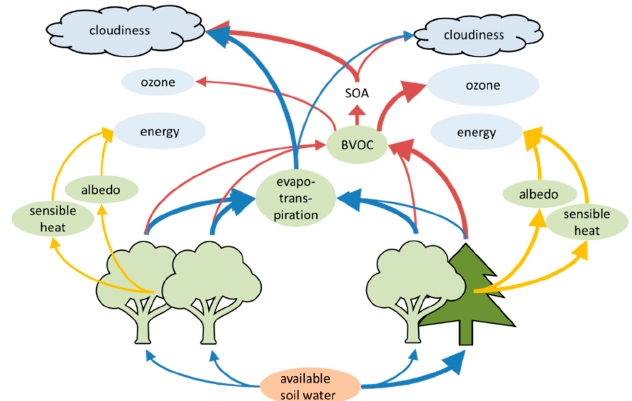
Figure 1. Impacts of beech forests (left) in comparison to mixed beech / fir forests (right) on heat-, water-, and biogenic volatile organic compound (BVOC) exchange (green ellipses) as well as on energy, clouds, and air chemistry (blue ellipses). Arrow thickness indicates if fluxes are higher or lower in comparison between the two investigated states but are not representing a specific quantity. Feedbacks of air chemistry and climate on ecosystems are neglected for clarity reasons. See text for more explanations and